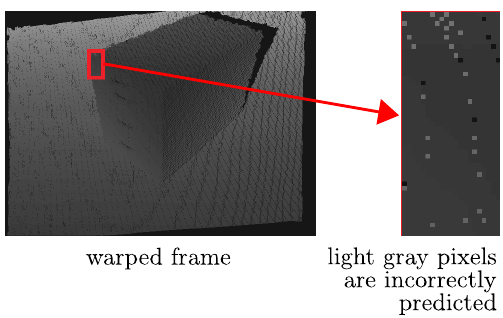
Figure 8. Ghost artifacts: the light gray pixels actually belong to the background surface and falsely warped onto the surface at the